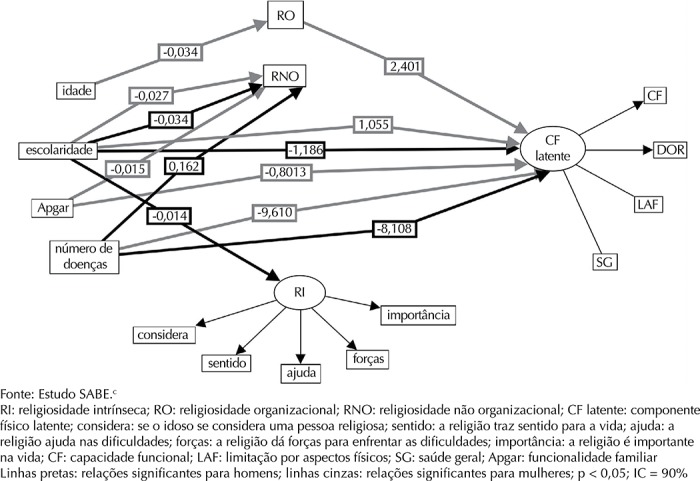
Representação do modelo estrutural e de mensuração usando a modelagem de equações estruturais com as influências das variáveis sobre o componente físico para homens e mulheres idosos. São Paulo, SP, Brasil, 2006.